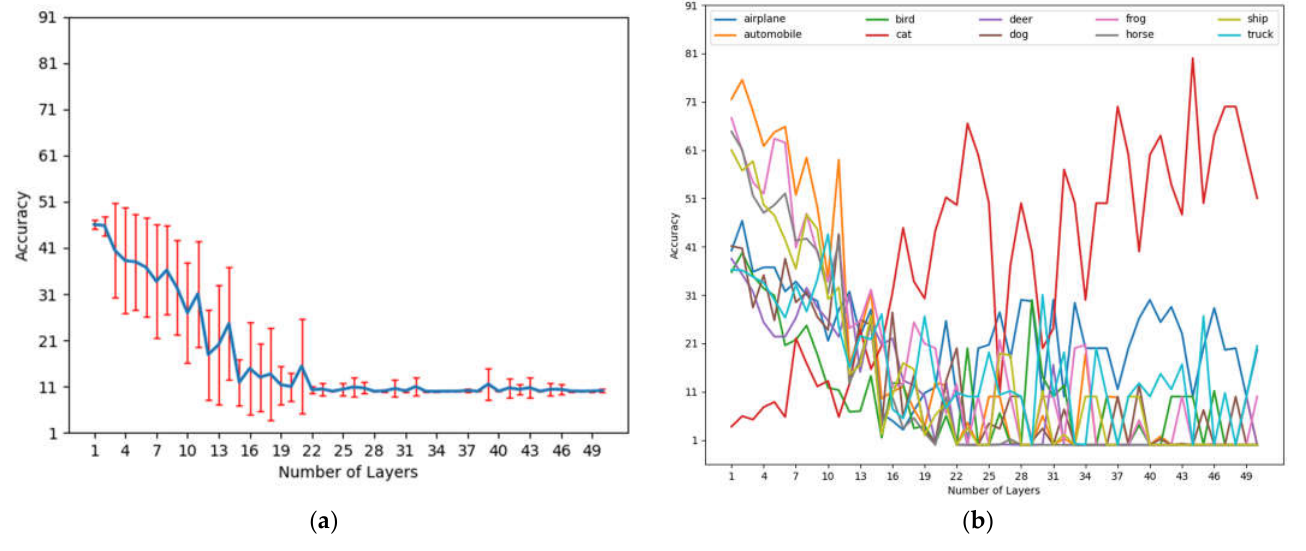
Figure 7. CIFAR-10 dataset performance results. ( a ) Accuracy achieved by the plain-50 network with respect to different depths using CIFAR-10 dataset; ( b ) Per-class accuracies achieved by the plain-50 network with respect to different depths using CIFAR-10 dataset.